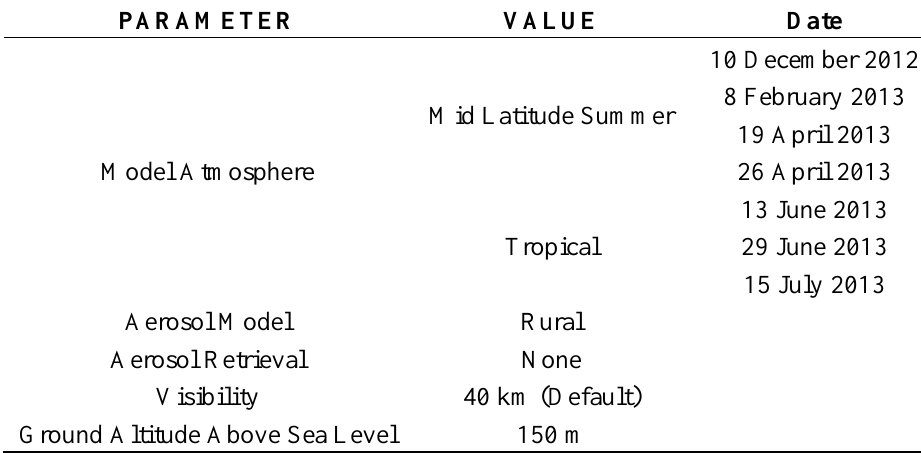
Table 3. MODTRAN input parameters used in this